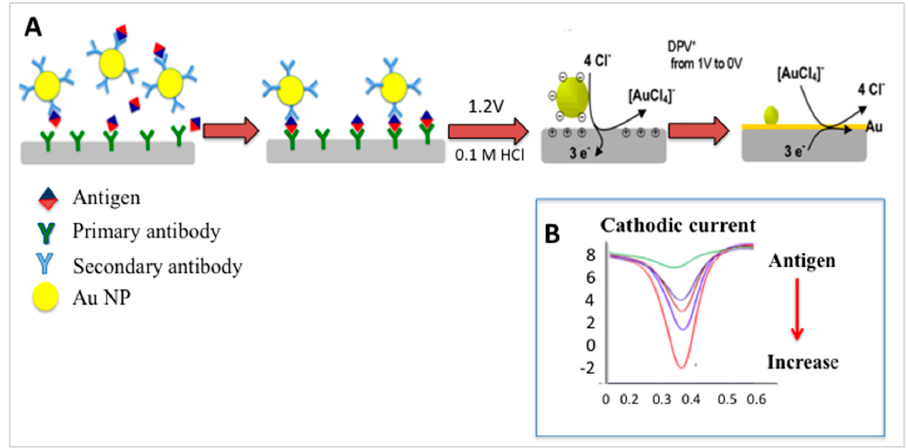
Figure 4. ( A ) Illustration of the principle of gold-linked electrochemical immunoassay (GLEIA). A primary antibody is immobilized directly on an electrode surface, and a typical sandwich-type immunoreaction carried out. The secondary antibody is labeled with Au NPs. In the presence of 0.1 M HCl, and upon application of approximately 1.2 V, the Au NPs are pre-oxidized from Au 0 to Au 3+ . A differential pulse voltammetry (DPV) from 0 V to 1.0 V immediately after the pre-oxidation step reduces the oxidised NPs back to Au 0 (this figure is a partial reproduction of our previous figure in Vestergaard et al. [1]); ( B ) A voltammogram of the reduction signal of Au NPs on carbon SPE. The signal increases proportionally to increase in antigen concentration (part of the figure is from our previous work: Idegami et al. [83]).